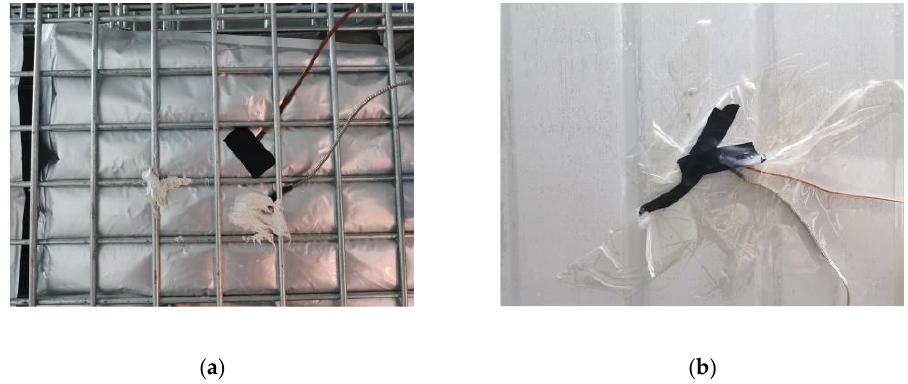
Figure 4. Surface temperature measurement points of PCM and Ordinary wall envelopes on the left ( a ) and right ( b ), respectively.